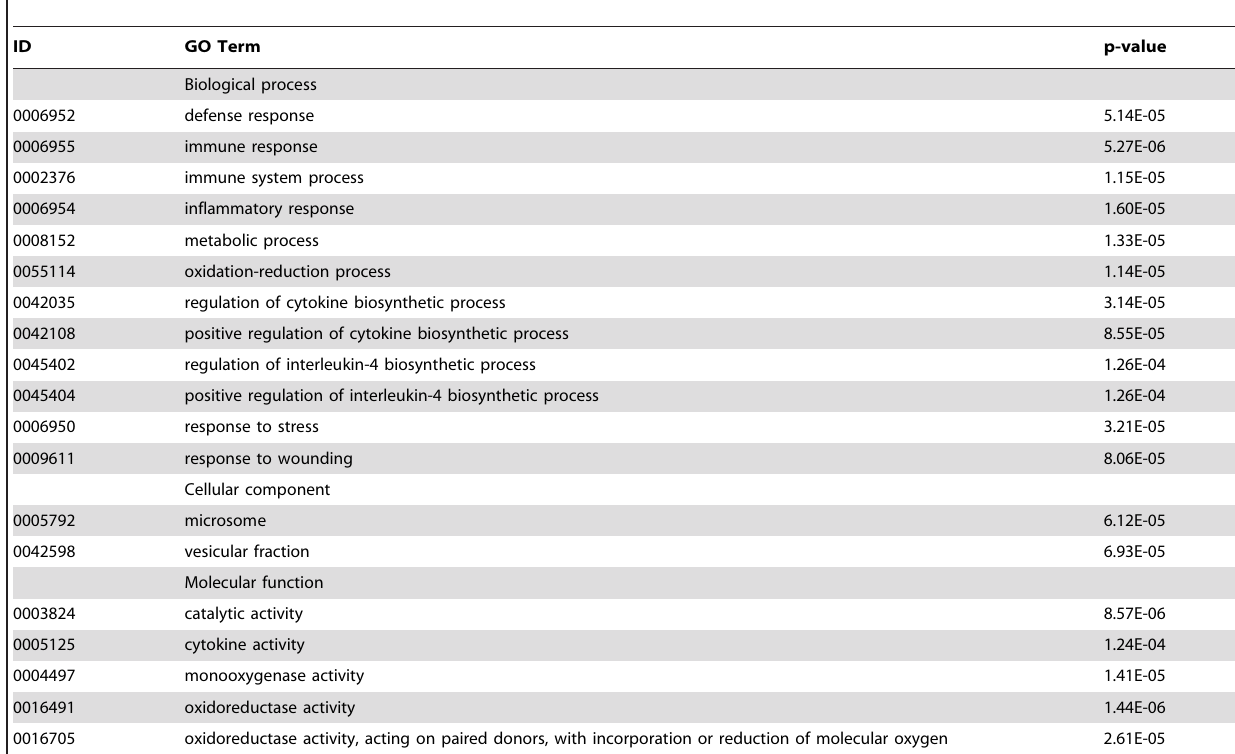
Table 1. Statistically significant GO terms derived from up-regulated genes (vs. ground control).